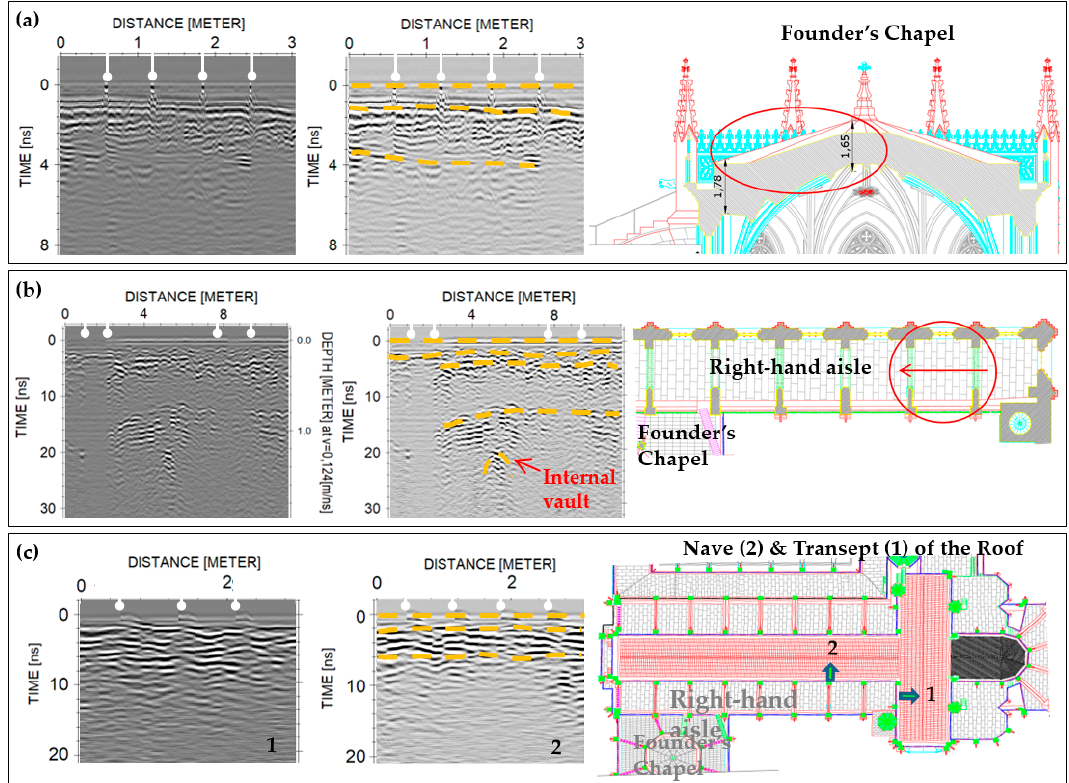
Figure 9. GPR data acquired on the roof of the Church and of the Founder’s Chapel: ( a ) 2300 MHz data on the roof of the Founder’s Chapel, ( b ) 800 MHz data on the roof above the right-hand aisle, and ( c ) 800 MHz data on the roof of the Church (above the nave and transept). (Vertical white marks are the field marks used for data integration, which correspond to the separation of successive external tiles, while horizontal yellow dashed lines indicate the separation of successive internal layers.).